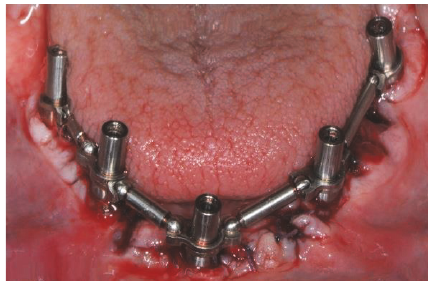
Figure 7: The prosthetic cylinders in titanium were screwed: over these cylinders, the adjustable rings and the rotating spheres were adapted both horizontally and vertically, paying attention to remain well above the bone crest.